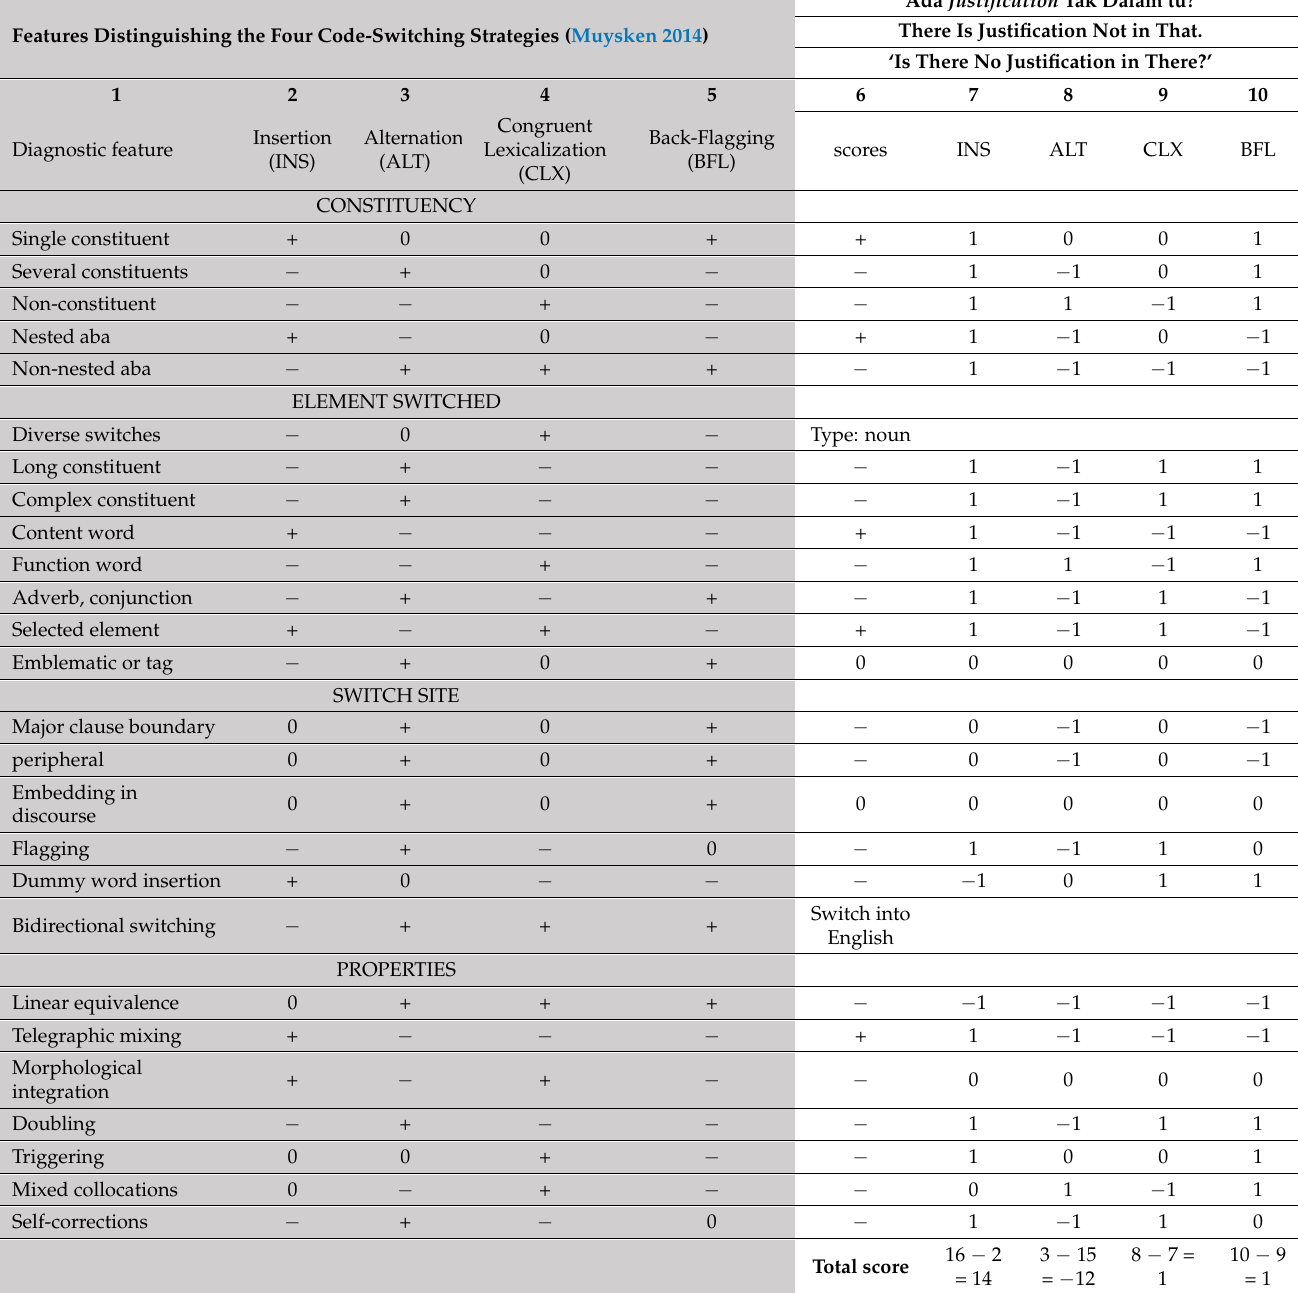
Table 2. Muysken’s (2014) features applied to Malay-English